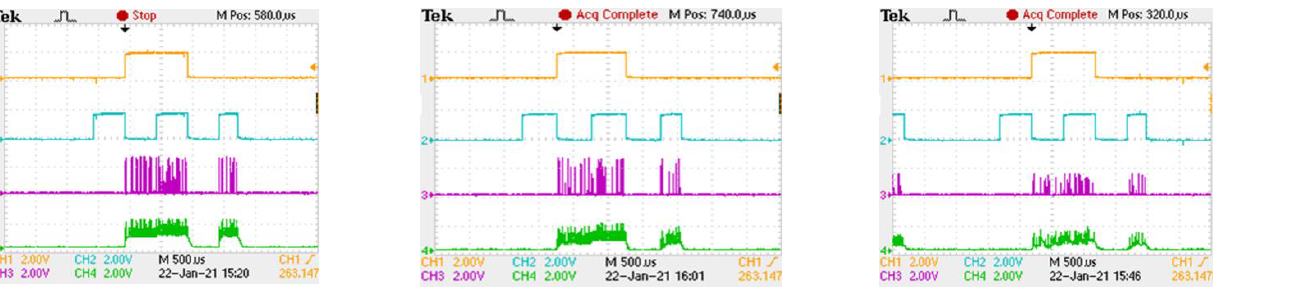
Figure 9. Test results of the Pavlov SNN chip (from left to right: TID 300 krad (Si), 500 krad (Si), 1 Mrad (Si)).